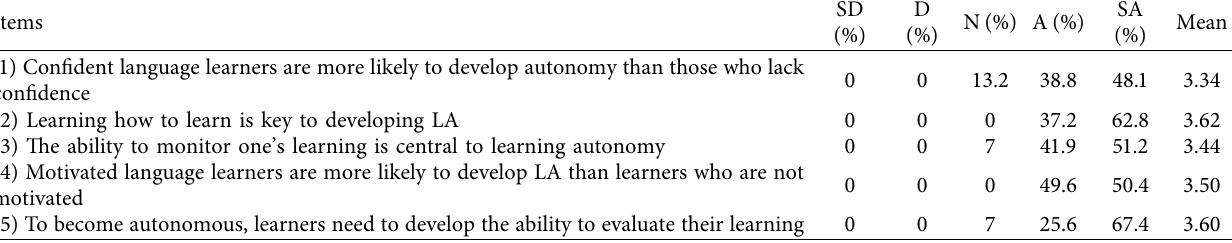
Table 3: Descriptive statistics of the psychological orientation of autonomy.